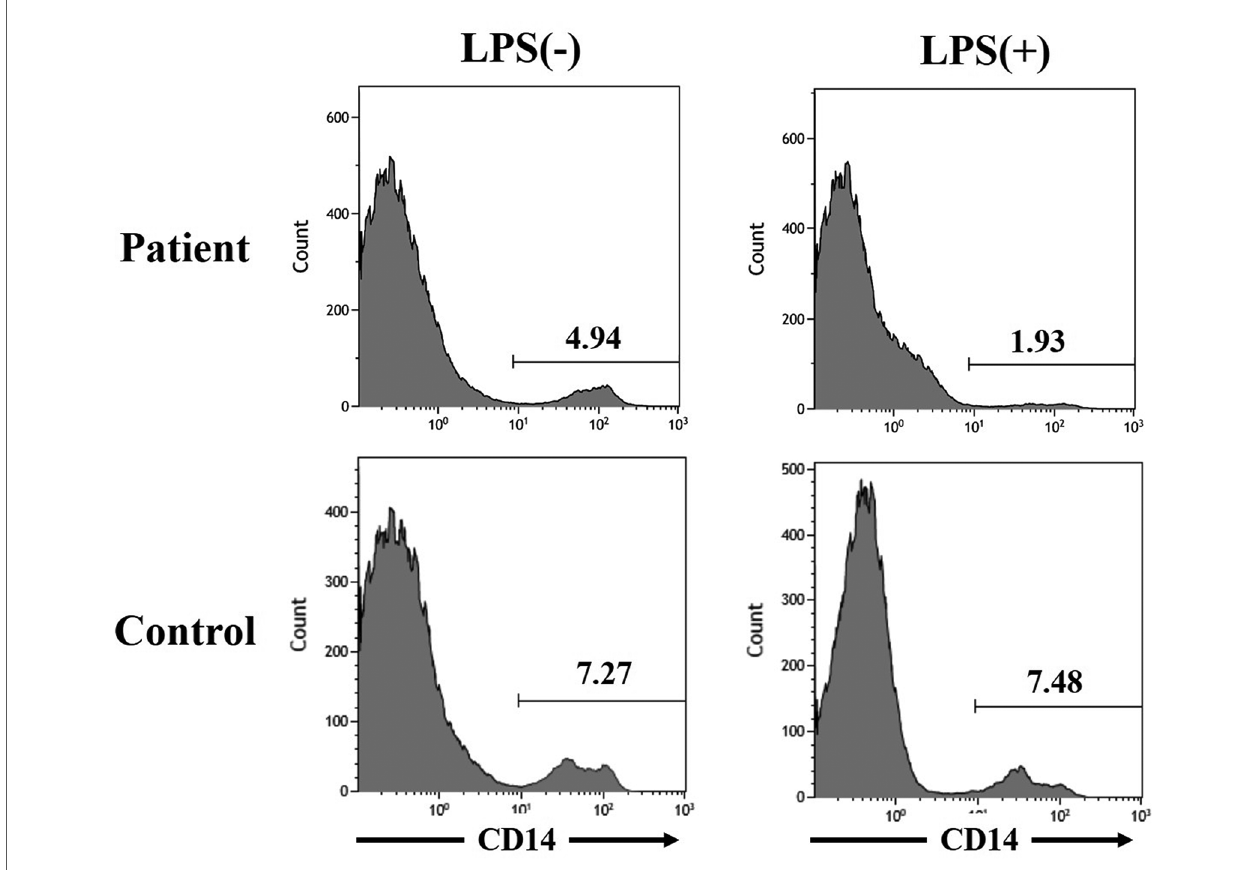
FIGURE 3 Monocytic cell death induced by lipopolysaccharide stimulation in the patient with muckle-wells syndrome. The fi gures of the upper left and right sides indicate the proportion of CD14 + cells, mainly monocytes, in peripheral blood mononuclear cells from the patient with Muckle-Wells syndrome without and with lipopolysaccharide stimulation, respectively. The fi gures of the lower left and right sides indicate the proportion of CD14 + cells, mainly monocytes, in peripheral blood mononuclear cells from an age- and sex- matched healthy child without and with lipopolysaccharide stimulation,